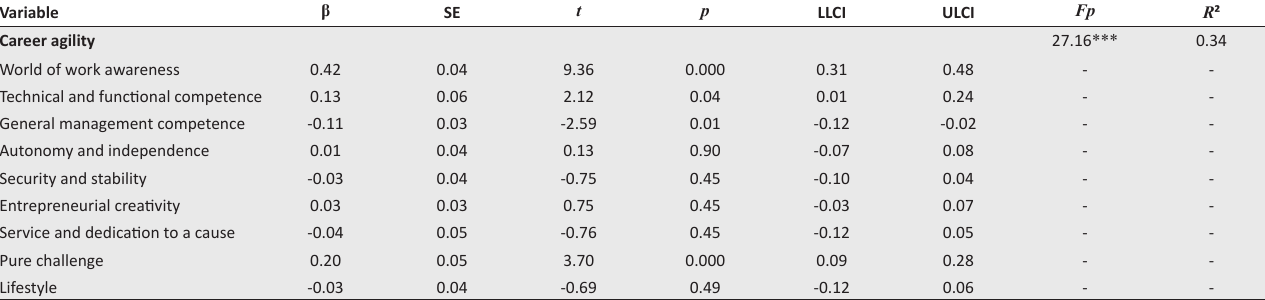
TABLE 3: Results of prediction effects on career agility ( n =